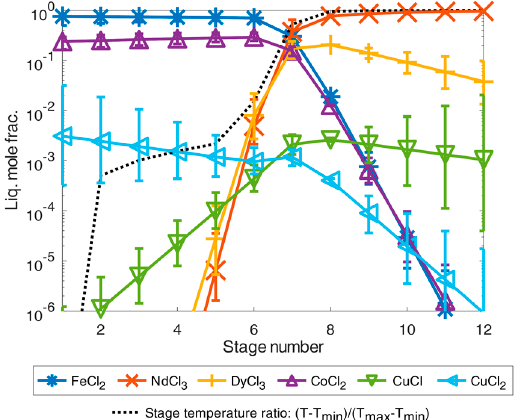
Figure 7. Illustration of separation of high-purity REEs by distillation simulated in an exemplary total-reflux column under simplified idealized phase equilibrium conditions according to Equation (1) for the feed composition case from [9]. The error bars show the results for a deviation of the calculated temperature of ±5%.